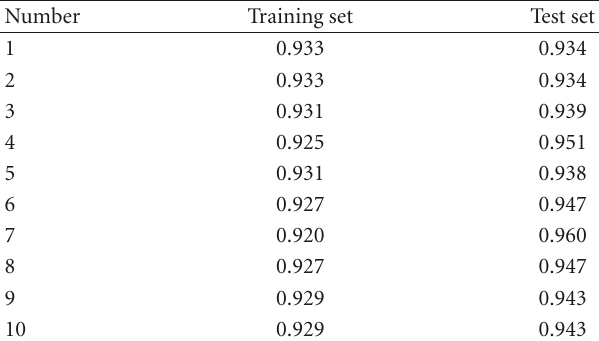
Table 11: Accuracy for the 10 pairs of training and test sets (Two correlations